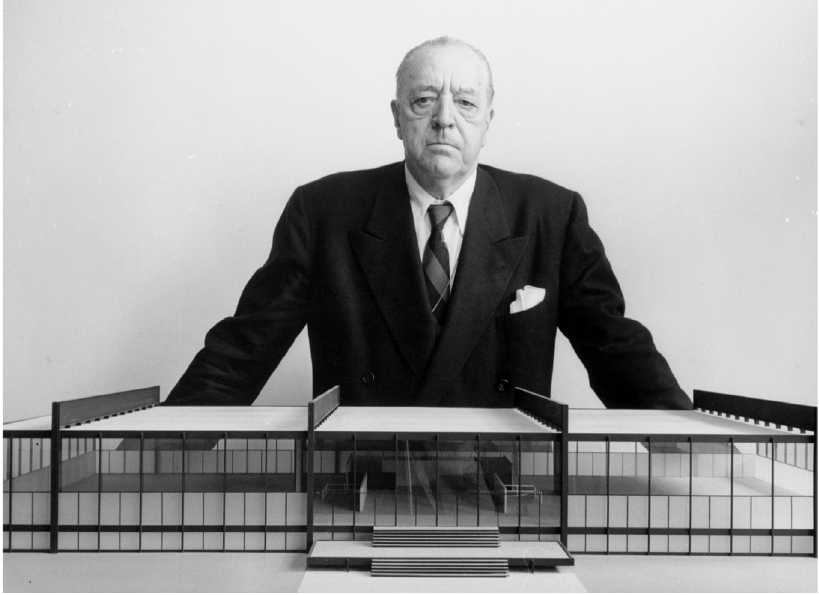
Figure 4. Mies van der Rohe with a model of Crown Hall (photographer: Arthur Siegel), courtesy Chicago History Museum